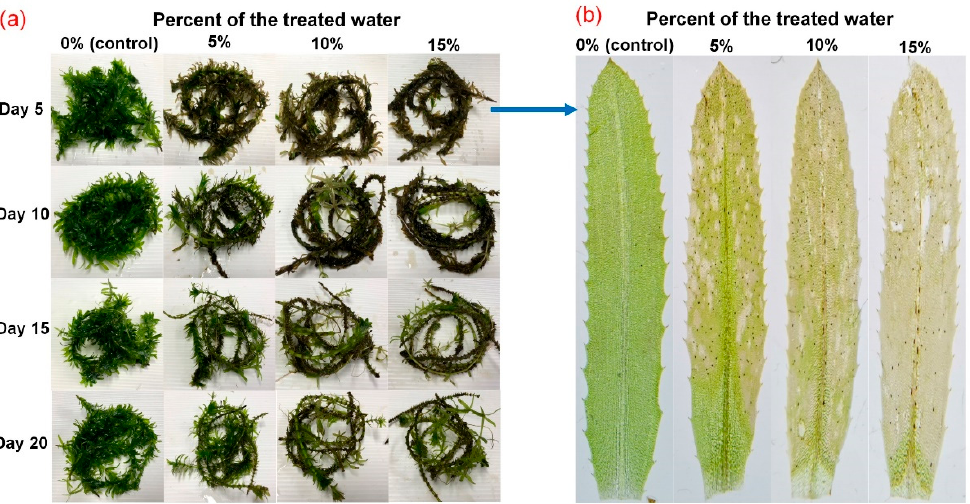
Figure 8. ( a , b ) Images of Hydrilla verticillata changes after exposure to different percentages of the treated water